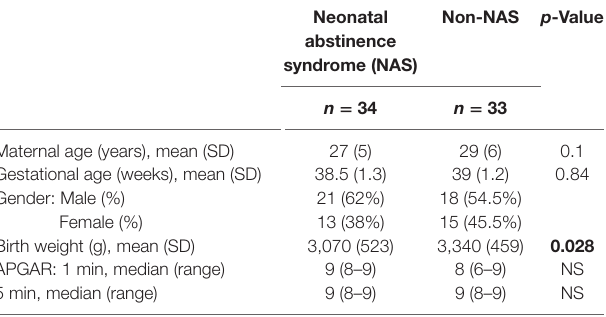
FigUre 1 | Scatter plots and mean plasma brain-derived neurotrophic factor (BDNF) ( ± SD) levels (ng/ml) among neonatal abstinence syndrome (NAS) infants during withdrawal phase compared to non-NAS; * p =